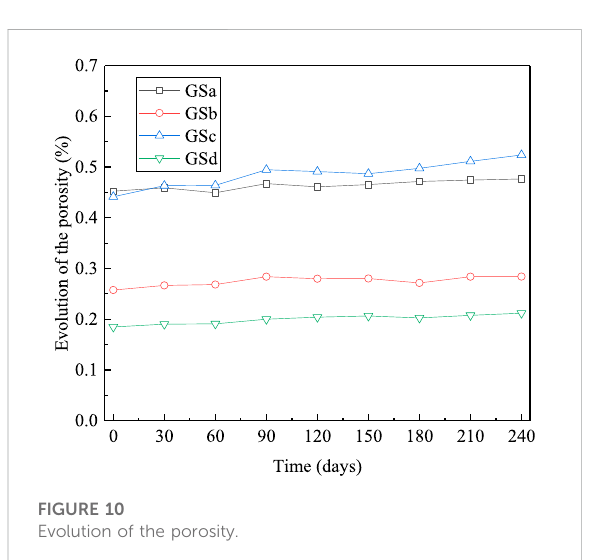
FIGURE 11 Pore quantity evolution of